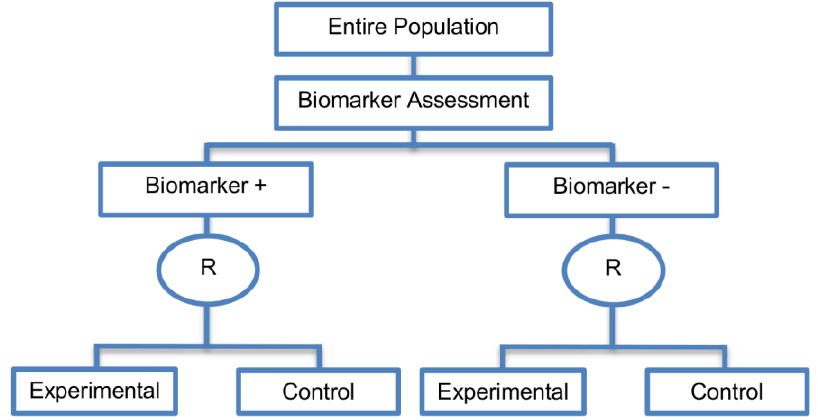
Figure 4. Marker Stratified designs. “R” refers to randomization of patients.